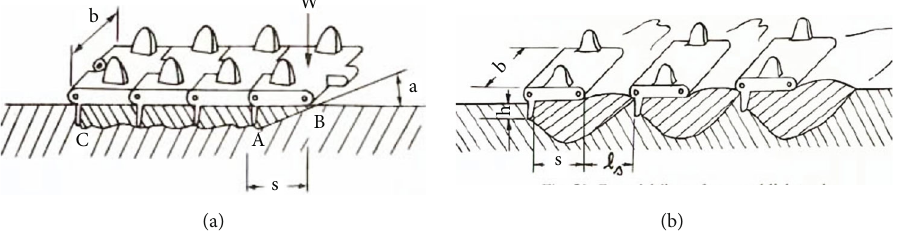
Figure 2: Comparison between a conventional track (a) and Bekker ’ s spaced-link track (b). Figures taken from [5].